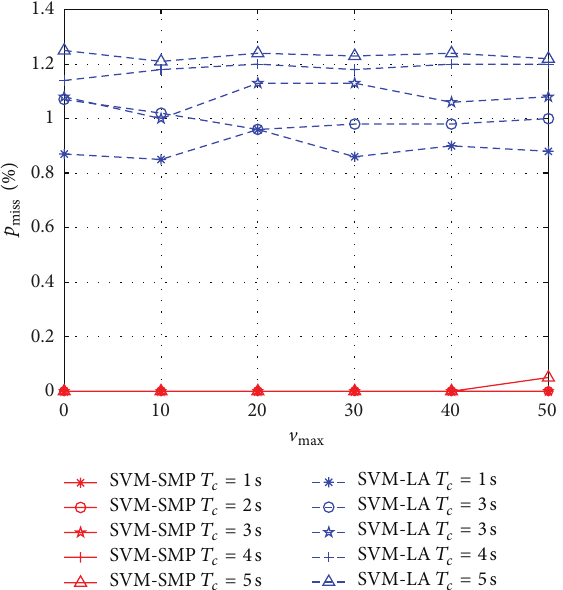
of 𝑝 occurs at about 𝜀 = 0 which is relatively small. accuracy for CUs versus V max . miss With the increasing of 𝜆 , the maximum value position of 𝑝 moves to the right. When 𝜆 = 10 , the maximum accuracy occurs at about 𝜀 = 0.1 . It is because the small of 𝑝 accuracy probability events happen more times when SUs’ randomness of SVM- movements are strong ( 𝜆 is big). The bigger the 𝜆 is, the miss bigger the maximum value position of 𝑝